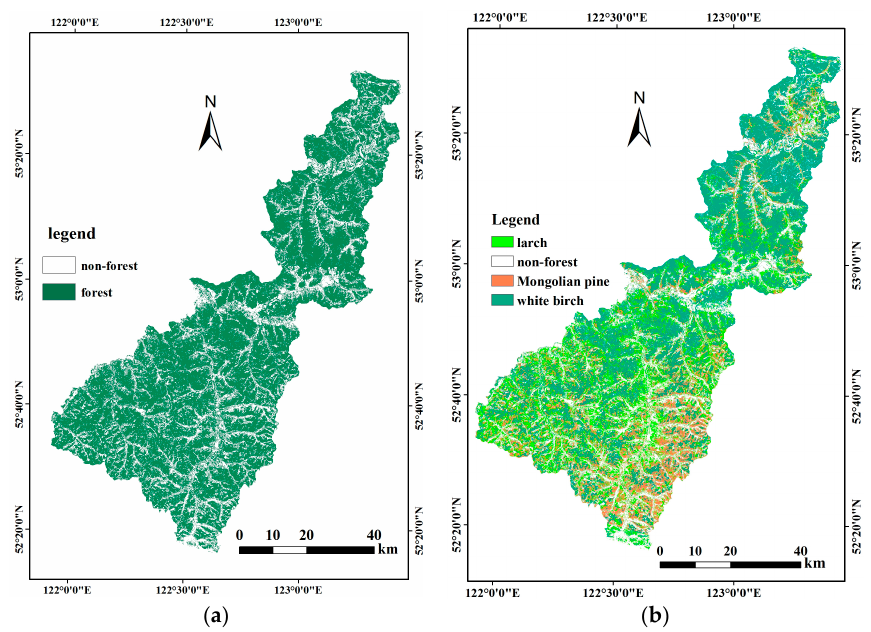
Figure 5. Distributions of forest/non-forest ( a ) and tree species ( b ) in the study area.